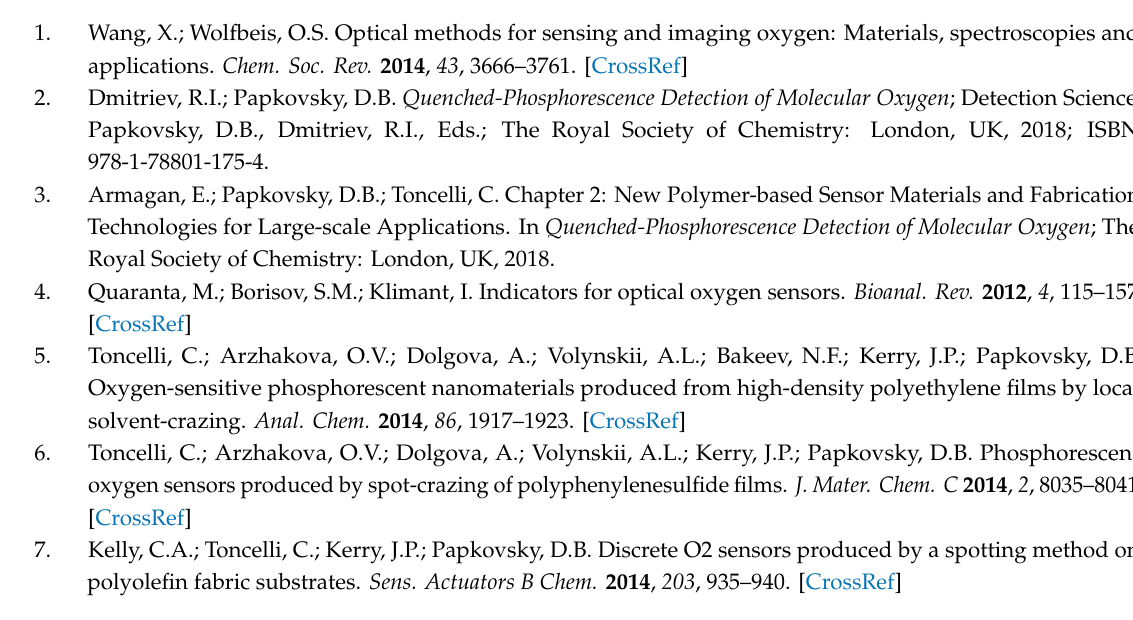
Table S1. LC-MS peak analysis of U-PPD2 (a) and U-PPD8 (b) with the molecular weight, retention time, and area % total. Table S2. Elemental composition of U-PPD2, U-PPD4, U-PPD6, U-PPD8 and U-PPD16 by XPS. Table S3. Lifetime measurements of U-PPD2 (a) and U-PPD16 (b). Figure S1. MALDI-TOF analysis of U-PPD2 (a) and U-PPD8 (b), ESI-QTOF analysis of U-PPD2 (c), U-PPD4 (d), U-PPD6 (e), U-PPD8 (f) and U-PPD16 (g). Reference m / z values for ESI-QTOF analysis for all kinetic samples (h). Figure S2. Dynamic mode AFM images of U-PPD2 (a), U-PPD6 (b), U-PPD8 (c) and U-PPD16 (d). Figure S3. UV-Vis spectra of U-PPD at 2, 4, 6, 8 and 16 hrs reaction time. Figure S4. High resolution XPS spectra of C1s for U-PPD2 (a), U-PPD4 (b), U-PPD6 (c), U-PPD8 (d) and U-PPD16 (e). Figure S5. 2D fluorescence color map of PPD16 (a), D-PPD16 (b), U-PPD16 (c) and D-U-PPD16 (d). Figure S6. 2D fluorescence contour plot of p-phenylenediamine. Figure S7. 2D fluorescence color map of Bandrowski's Base synthesized according to a previous literature method. Figure S8. 2D fluorescence color map of isolated compounds with emission centers located at λ exc = 340 nm, λ em = 402 nm (a), λ exc = 420 nm, λ em = 511 nm (b) and λ exc = 520 nm, λ em = 606 nm (c). Figure S9. 2D fluorescence contour plot of U-PPD16 embedded into Mowiol 40-88 (PVA). Figure S10. 2D flourescence contour plot of U-PPD16 embedded into Mowiol 40-88 under ambient condition (a) and 21 kPa O 2 (b). Figure S11. Response time of the third emission center of U-PPD16 embedded into Mowiol